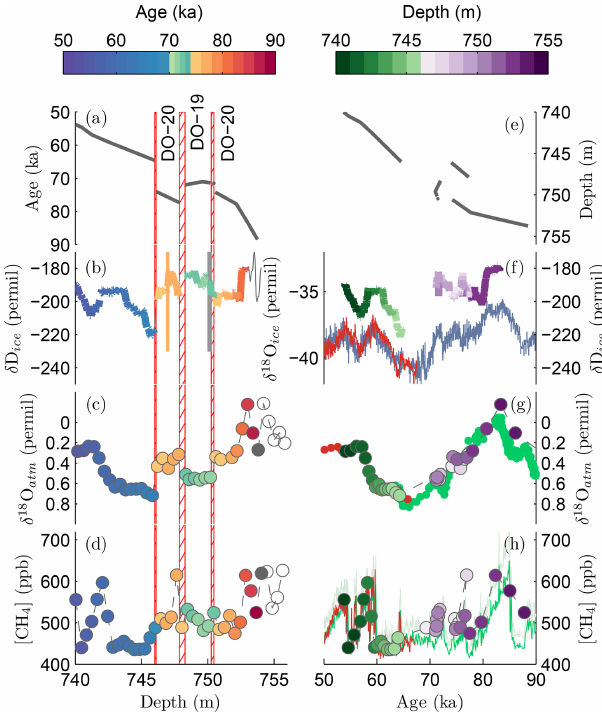
Figure 6. (a) Depth–age relationship from 740 to 756m and ev- idence of an age reversal within the RICE ice core from (b) δ D, (c) δ 18 O atm , and (d) methane data. (b–d) Measurements are plotted against depth and color coded according to the age of the sample. Open circles represent samples for which an age could not be de- termined. (a–d) Red hatched bars represent discontinuities, where periods of climate history appear to be missing. Solid gray bars in panel (b) are measurement gaps in the δ D record associated with large changes in δ D. (e–h) The depth–age relationship and mea- surements are plotted against the age of the sample and color coded according to depth. WAIS Divide data (red), NGRIP (green), and the EDML δ 18 O ice record